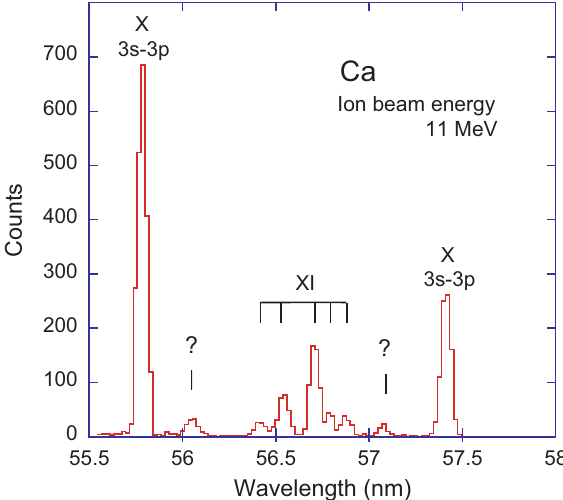
Figure 4. Ca beam-foil spectrum near the 3s-3p resonance transitions of CaX. Line width 0.05nm.